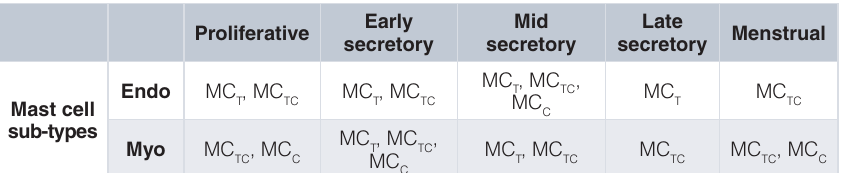
cells; Vs: MC cells; arrows: MC TC T C